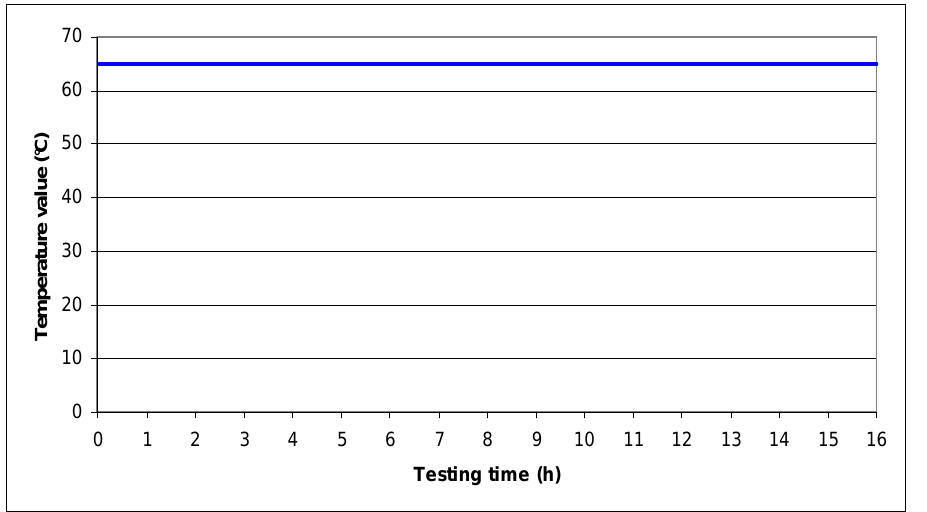
Figure 5. Example of program for Burn-in